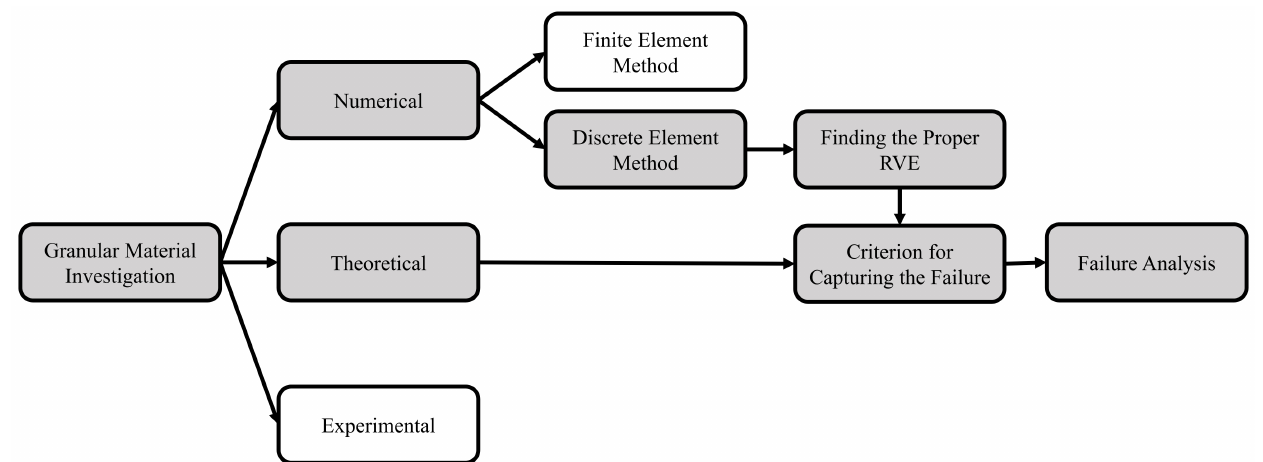
Figure 3. The flowchart of coke aggregate failure analysis approaches (the gray boxes outline the selected strategy in this